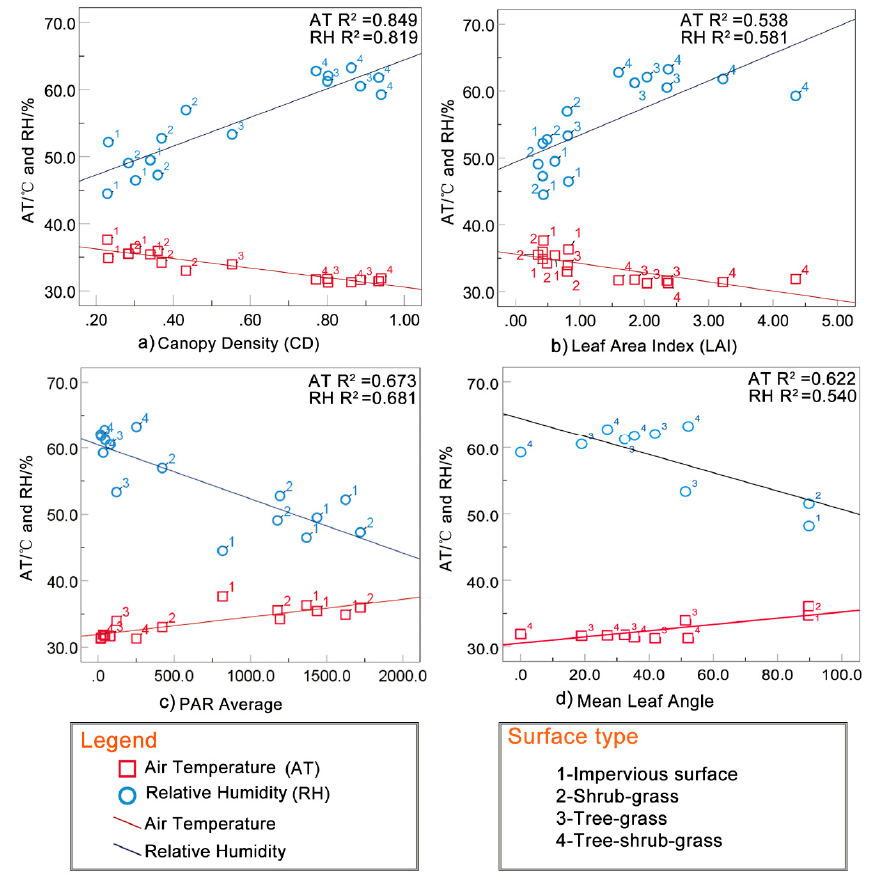
Figure 8. Linear regression analysis between vegetation coverage characteristics and air temperature (AT) and relative humidity (RH). Four factors: ( a ) canopy density (CD), ( b ) leaf area index (LAI), ( c ) photosynthetically active radiation (PAR), ( d ) mean leaf angle (MLA).